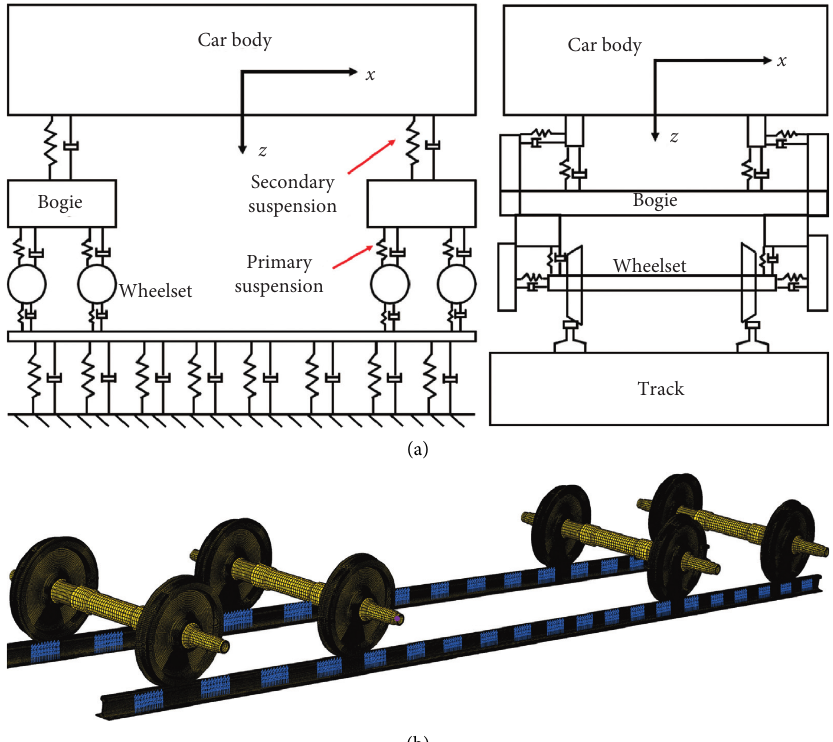
Figure 4: The finite element model of the wheel-rail system. (a) Discrete elastic supportive beam. (b) FEM of wheel-rail